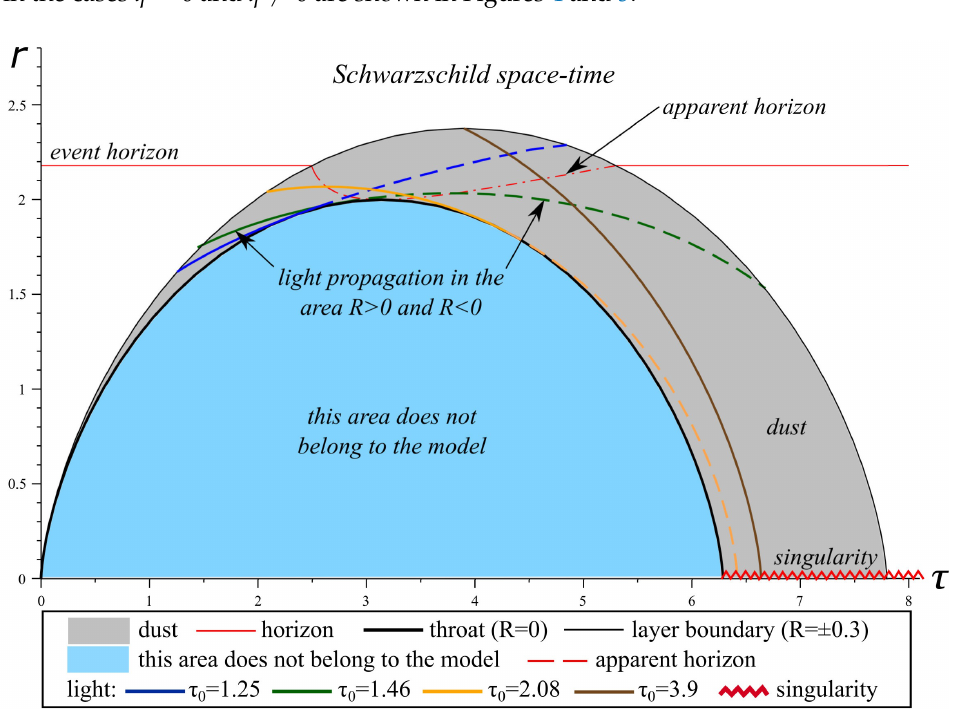
Figure 4. The figure shows: (1) The time dependence r ( τ , R ) for shells (Lagrangian spheres) R = const in the dust layer (gray area), the throat R = 0 and the outer surface R = ± 0.3 in the case q = 0. (2) The time dependence r ( τ ) of ingoing radial photons coming from the outer shell R = 0.3 towards the throat R = 0 at different times τ 0 ; reaching the throat, a photon path passes from the region R > 0 (solid line) to the region R < 0 (dashed line). (3) The singularity, presented by a broken red line. (4) The event horizon in vacuum and the apparent horizon inside the dust layer, presented by solid and dashed red lines,